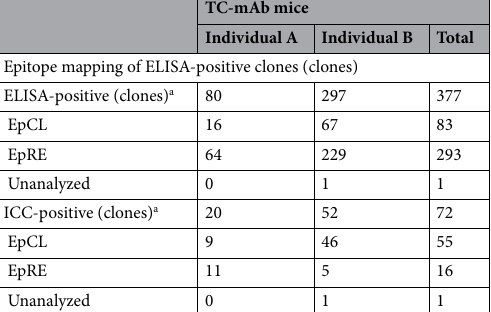
Table 1. Summary of analyzed clones. a The total numbers of ELISA-positive and ICC-positive clones were already reported in our previous study 4